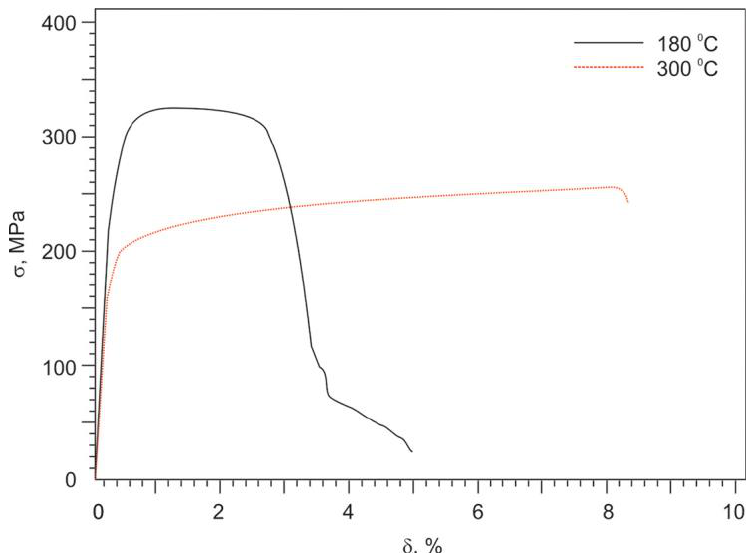
Figure 13. Stress – strain curves for composite sample after rotary forging to a diameter of 2.5 mm ( e = 4.16) and subsequent annealing at different temperatures.